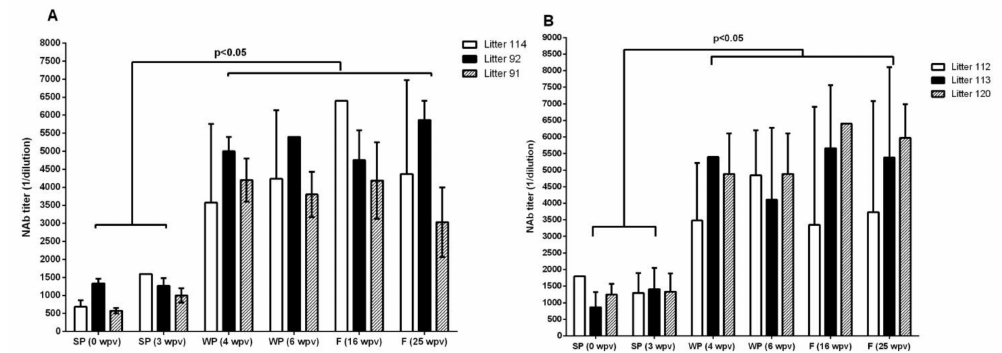
Figure 4. Serum NAb titers in piglets with high levels of MDA and immunized with two injections of E2CD154. ( A ) First dose at 15 days of age and ( B ) first dose at 21 days of age. Bars represent the GM and confidence intervals of the NAb titers. Wpv = weeks post vaccination, SP = suckling piglets, WP = weaning piglets, and F = fattening pigs. Kruskal–Wallis test was applied to compare NAb titers among the six groups and Dunn’s multiple comparison test was used to look for individual differences between